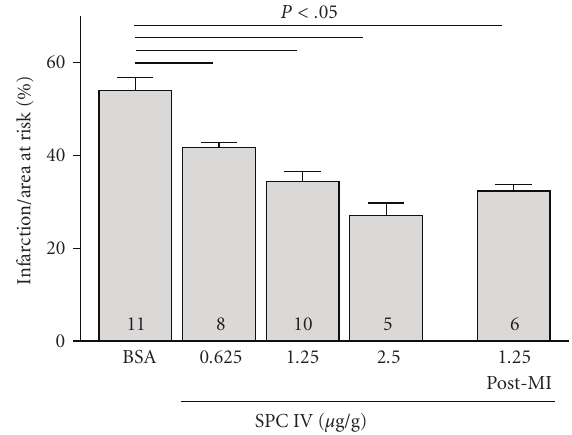
Figure 1: SPC protects against myocardial ischemia/reperfusion injury in vivo . SPC (0.625, 1.25 and 2.5 μ g/g body weight) and 1% bovine serum albumin in PBS were injected intravenously 30 minutes before and after myocardial ischemia with reinstitution of reperfusion. Infarct size, after MI/R as a function of area at risk is reduced in SPC treated